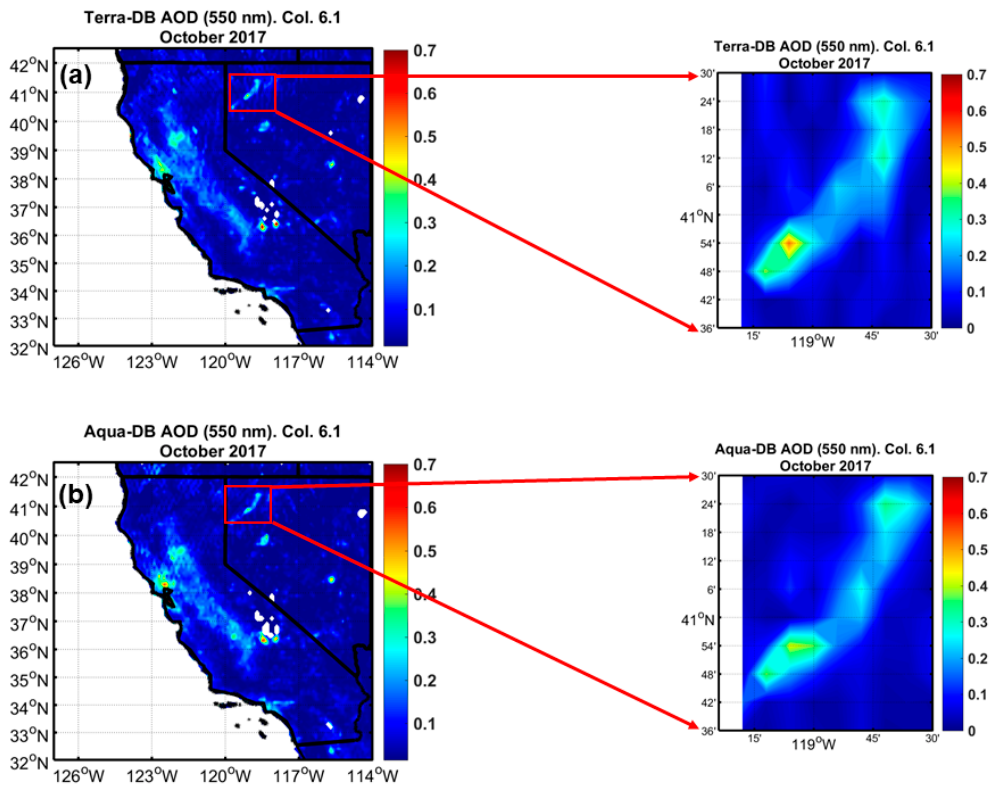
Figure 16. Monthly averages during October 2017 of MODIS collection 6.1 deep-blue (DB) aerosol optical depth (AOD) (550 nm) over California and Nevada, with the Black Rock Desert in the zoomed image: ( a ) Terra DB AOD. ( b ) Aqua DB AOD.